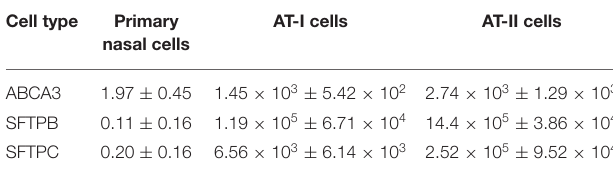
TABLE 1 | Expression levels of target genes in copies/ng RNA